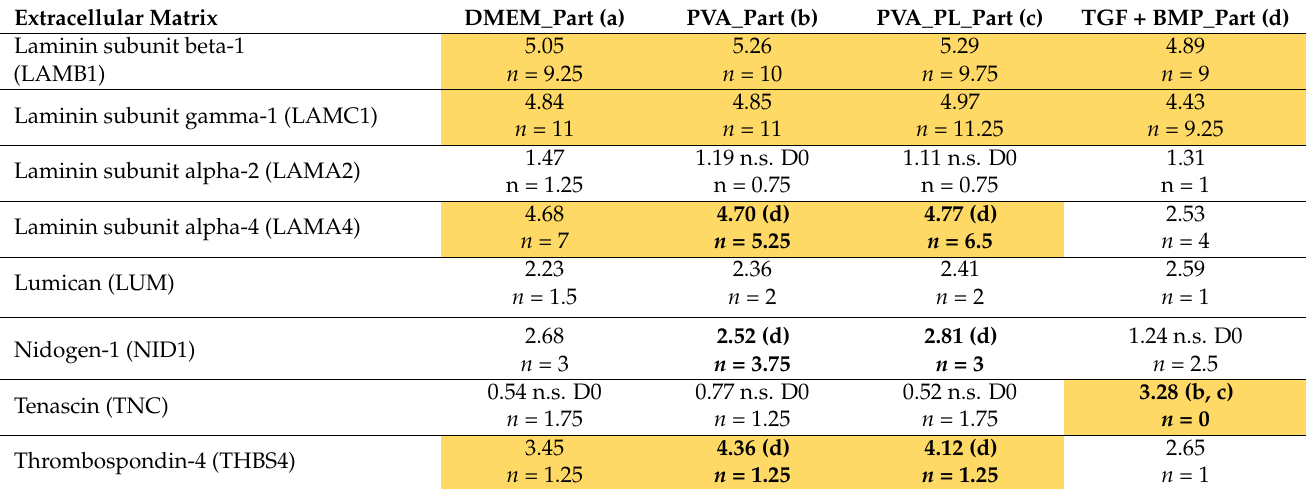
Table 4. Proteins involved in extracellular matrix remodelling produced by ASCs and ECs